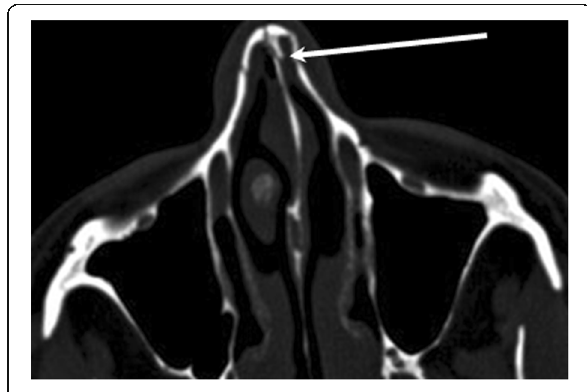
Fig. 16 Nasal bone fracture. Axial unenhanced CT image shows nondisplaced nasal bone fractures extending to the anterior bone septum